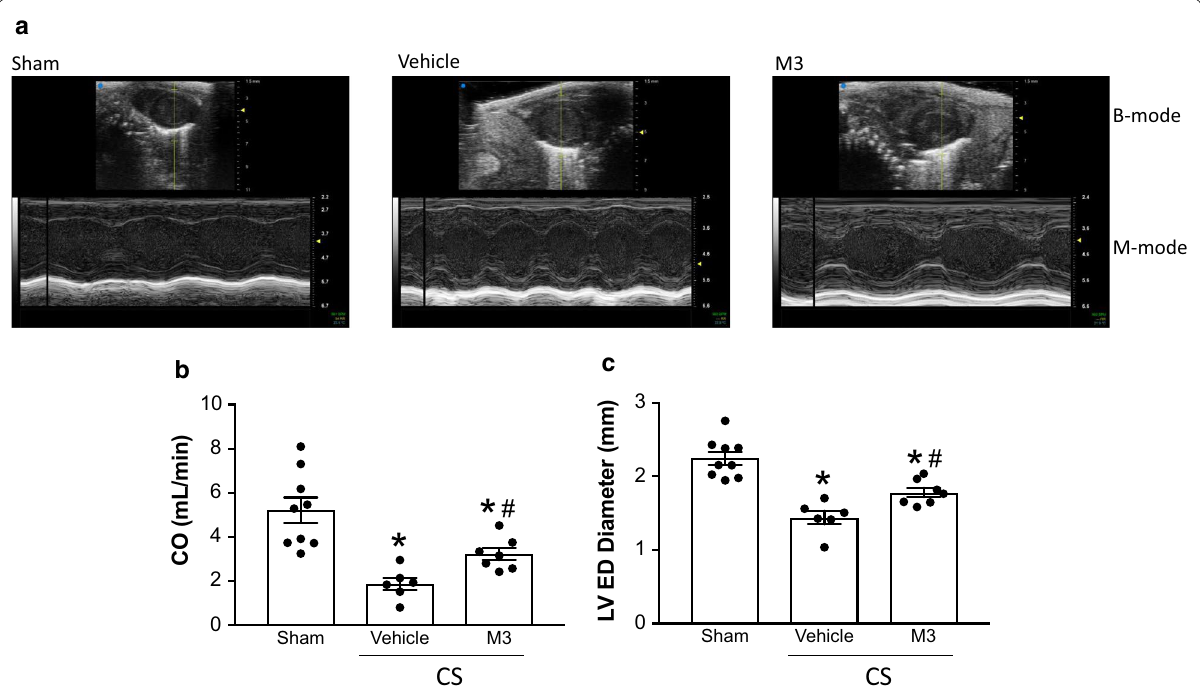
Fig. 4 M3 improves cardiac function in neonatal sepsis. 16 h after cecal slurry injection, echocardiogram was performed on mouse pups. a Representative still images of B and M‑mode echocardiogram findings. The B mode is the top portion of the images, while the M mode is the wave pattern, which is shown at the bottom portion of the images. b CO was reduced by sepsis induction while M3 treatment was able to ameliorate some sepsis‑induced dysfunction. c Left‑ventricular end diastolic diameter was reduced in vehicle‑treated septic pups as compared to M3‑treated pups. Data are expressed as means SE (sham 9, vehicle 6, and M3 7 pups). Multiple groups were compared by one‑way ANOVA and Tukey ± = = = method (*p < 0.05 vs. sham; # p < 0.05 vs.